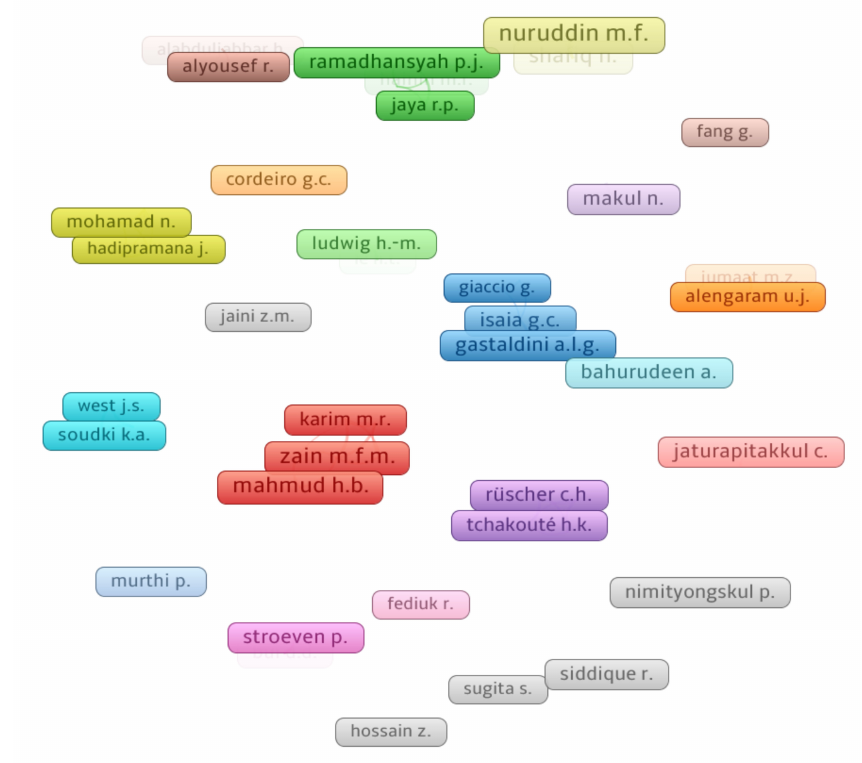
Figure 8. Scientific visualization of authors that published articles in the related research area. Table 4. The top ten highly cited published articles up to 2021 in the research of RHA